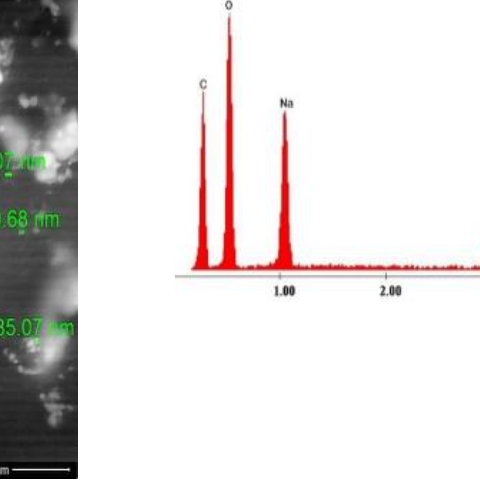
Figure 7. An agglomeration of AgNPs ( a ) and the electron diffraction pattern revealing the FCC (face-centered cubic) structure of Ag ( b ); the most intense diffraction rings correspond to (111), (200), and (220) crystallographic planes.